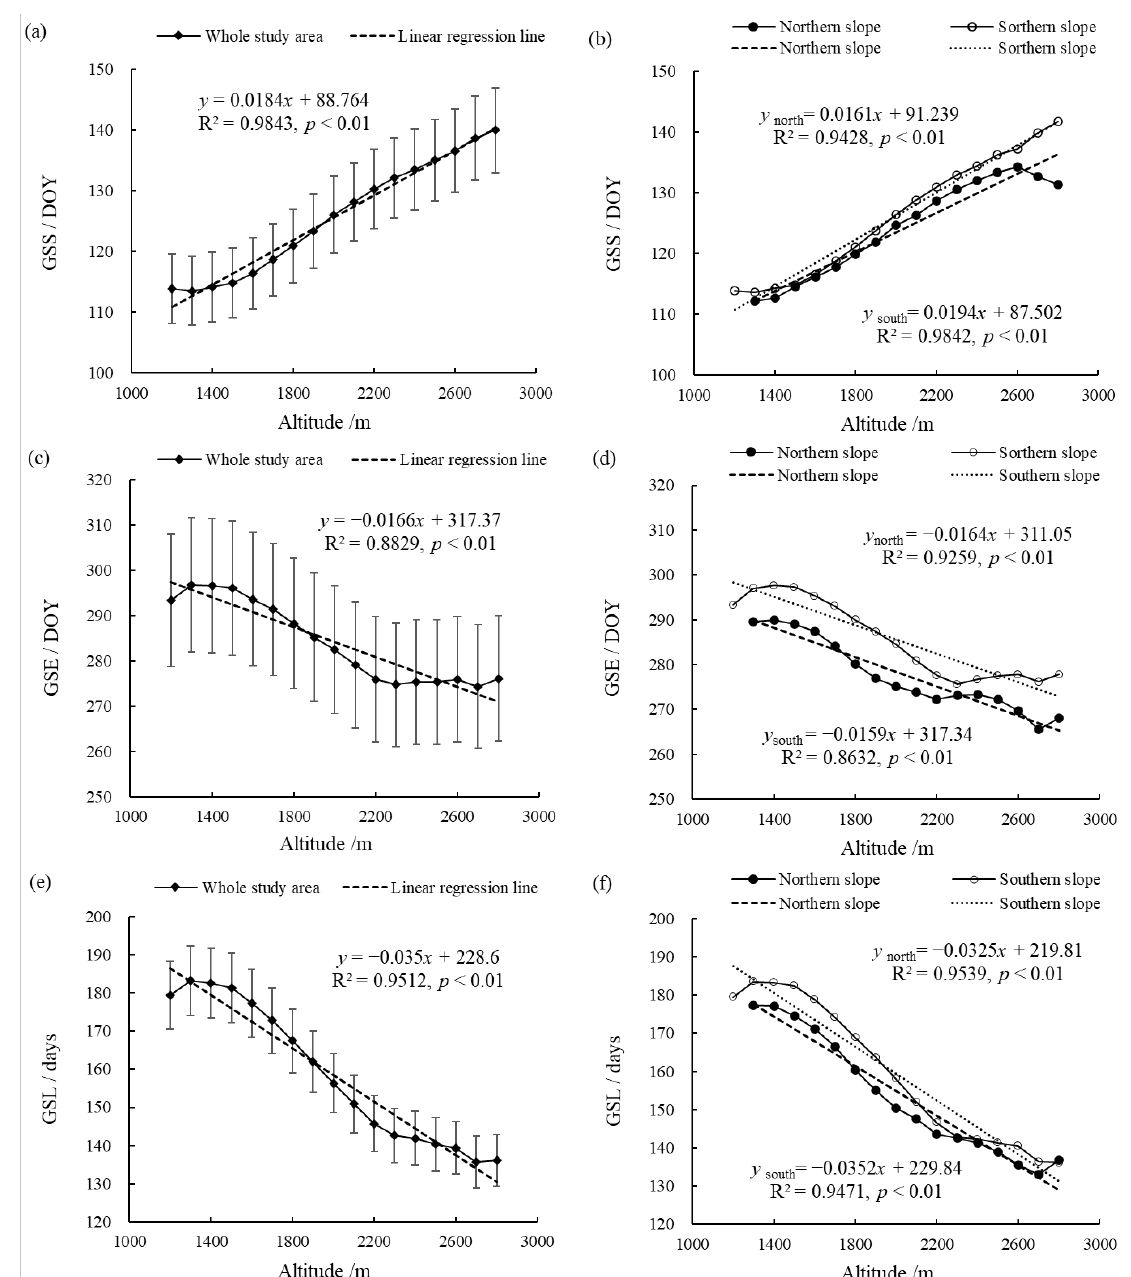
Figure 5. Changes of vegetation phenological parameters at the different altitudes in Niubeiliang Reserve from 2000 to 2017. ( a ) GSS of the whole area with the altitude; ( b ) GSS of the northern and southern slopes with the altitude; ( c ) GSE of the whole area with the altitude; ( d ) GSE of the northern and southern slopes with the altitude; ( e ) GSL of the whole area with the altitude; ( f ) GSL of the northern and southern slopes with the